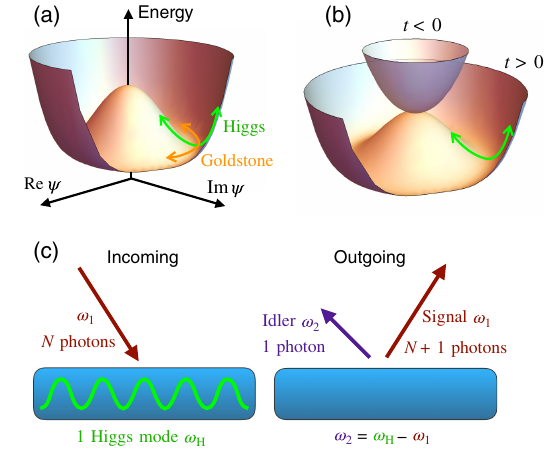
FIG. 1. (a) Schematic potential in a broken symmetry state. The collective excitations are Goldstone and Higgs modes. (b) Sudden change in system parameters at time t ¼ 0 leading to a rapid inversion in the potential, thus inducing Higgs oscillations. (c) Light amplification in a superconductor with an excited Higgs mode. Left panel: probe pulse containing N photons of frequency ω 1 , incident on a superconductor with an excited Higgs mode (represented by a wave). Right panel: output consisting of N þ 1 photons of frequency ω 1 , plus a single photon of frequency ω “ backward, ” due to in-plane momentum conserva- 2 traveling tion. When many Higgs excitations undergo stimulated decay, a large number of both ω 1 and ω 2 photons are